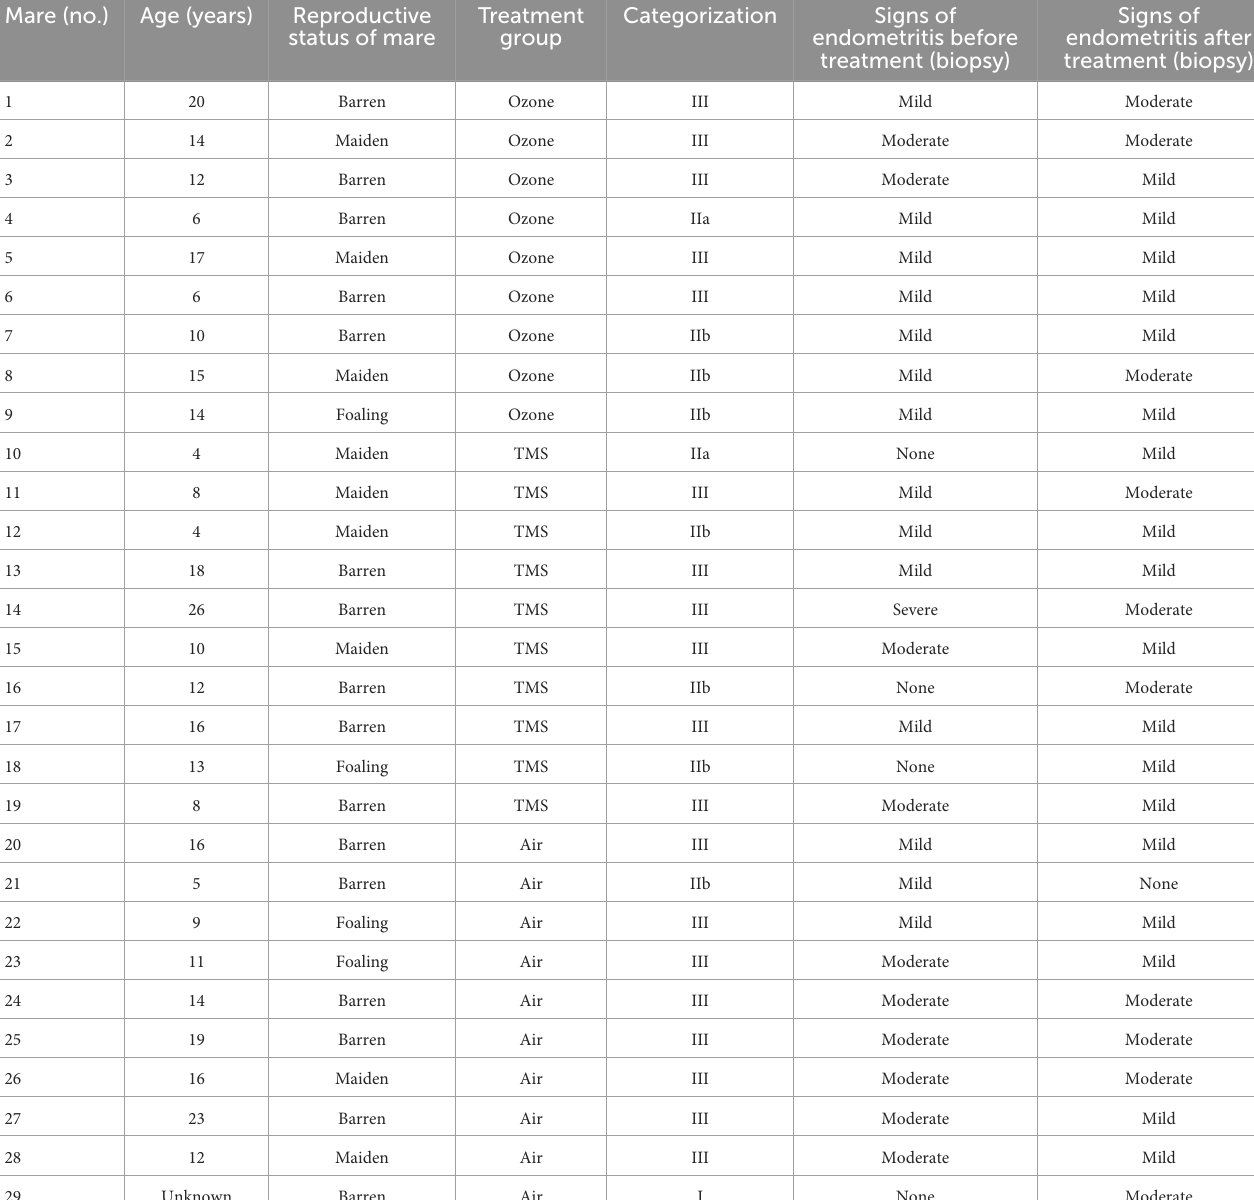
TABLE 1 Information on individual mare characteristics, categorization of mares before treatment according to Kenney and Doig (26) and Schoon et al. (27) and signs of endometritis before and after treatment as determined by endometrial biopsy. Mare (no.) Age (years) Reproductive Treatment Categorization Signs of status of mare group endometritis before treatment